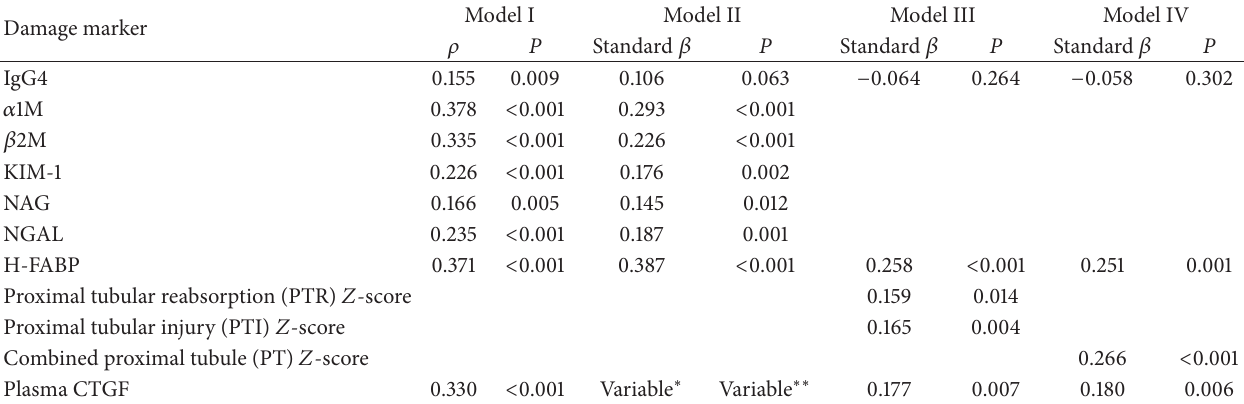
Table 3: Association of urinary CTGF with various damage markers in diabetic